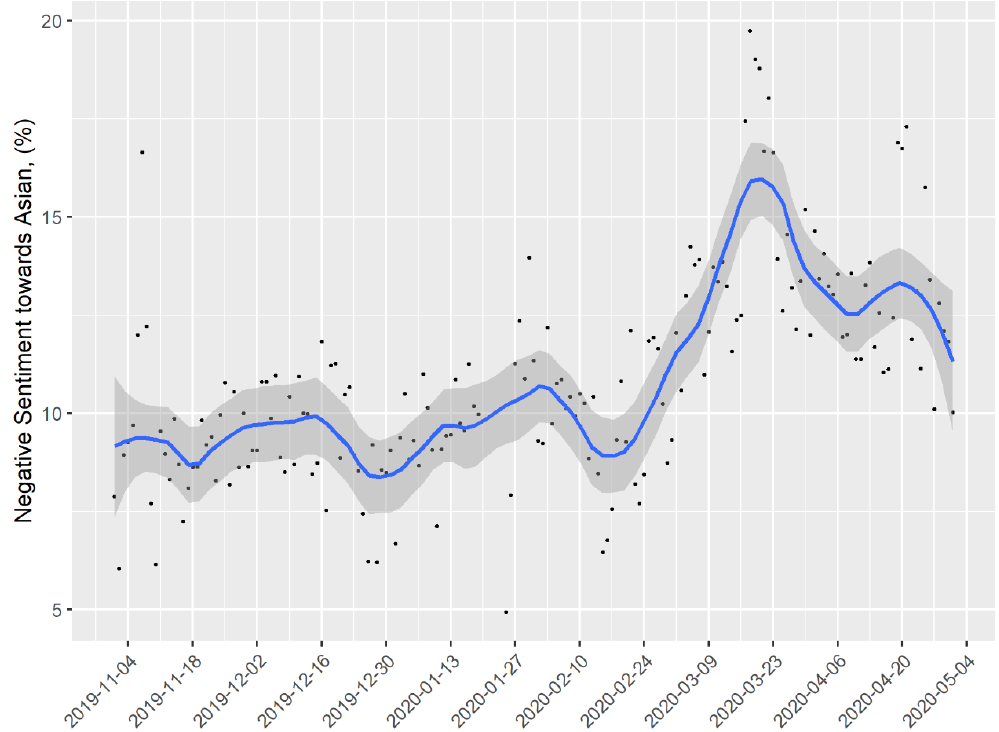
Figure 1. Temporal changes in negative Asian sentiment, November 2019–April 2020. n235,263 tweets. LOESS (locally estimated scatterplot smoothing) was performed to fit smooth curves to the daily prevalence of negative sentiment. The shaded area represents 95% confidence bands around the smoothed trend line.